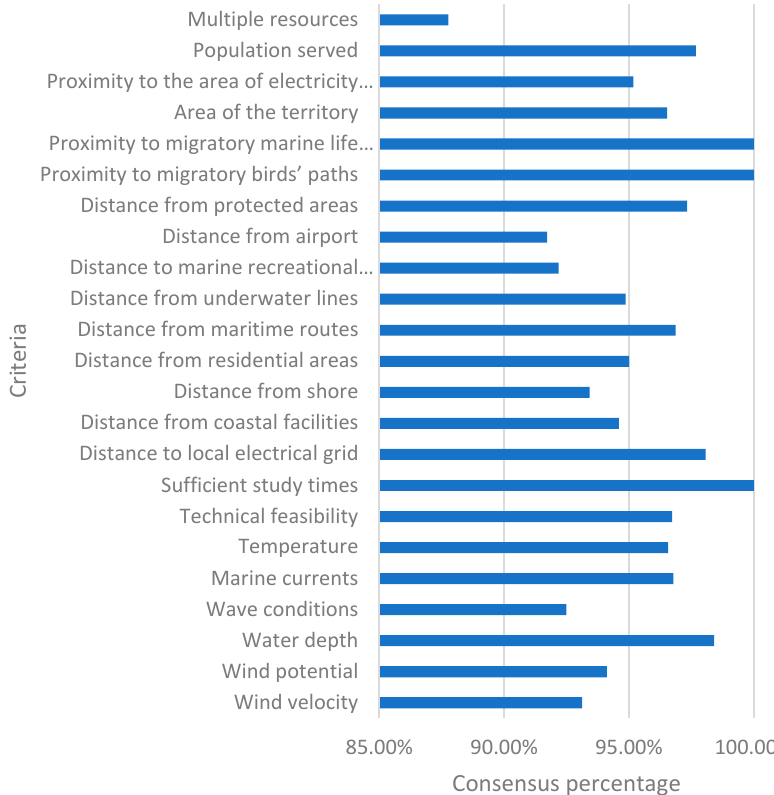
Figure 5. Consensus percentage related to analytic hierarchy process evaluation of locations.